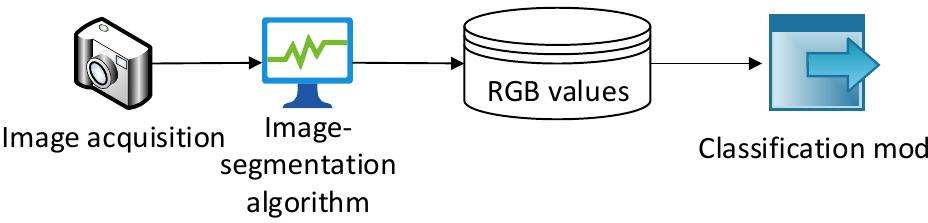
Figure 1. Flowchart of data acquisition in previous studies.